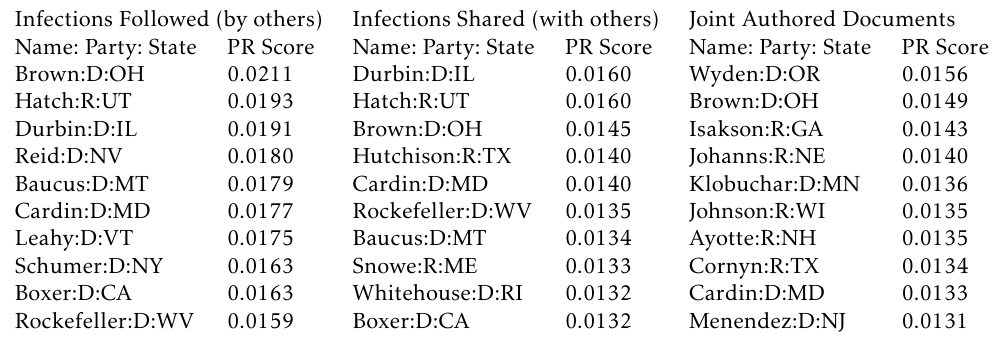
Table 4. Correlation between Network Centrality and Leadership position for all senators